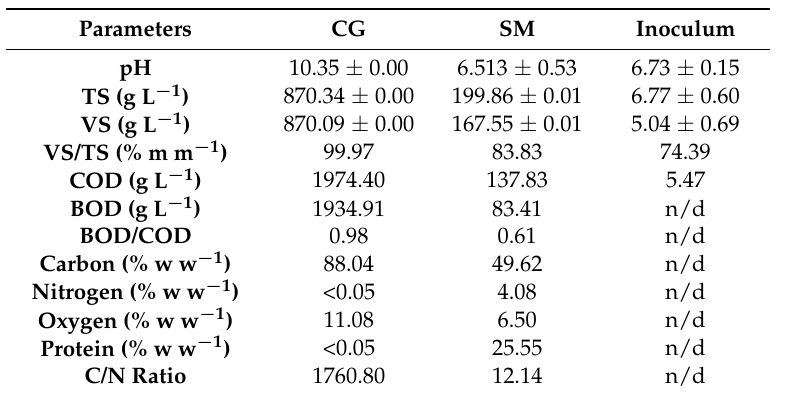
Table 1. Physical and chemical characteristics of hydrogen production assays conducted with different concentrations of substrates, crude glycerol (CG), and swine manure